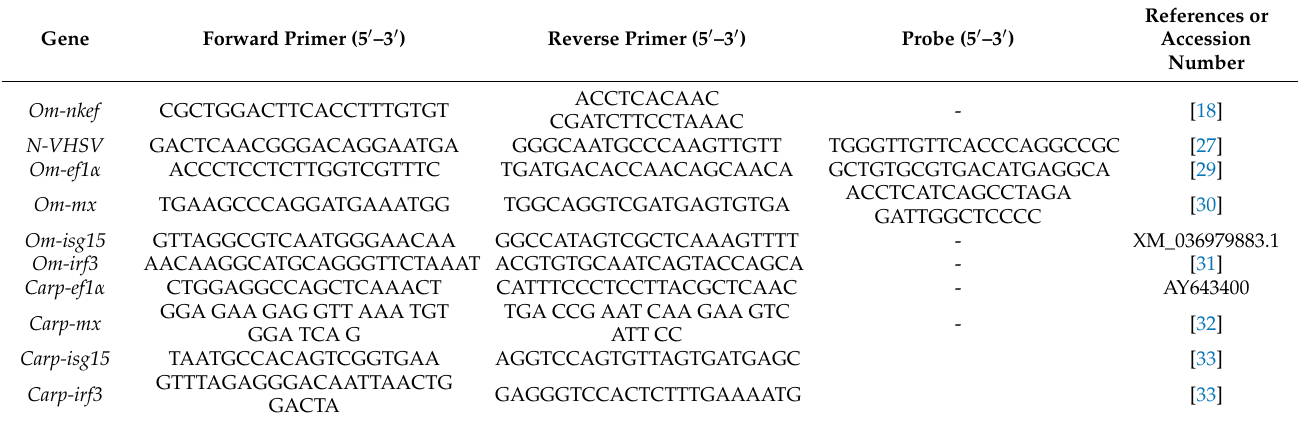
Table 3. Sequences of primers and probes for